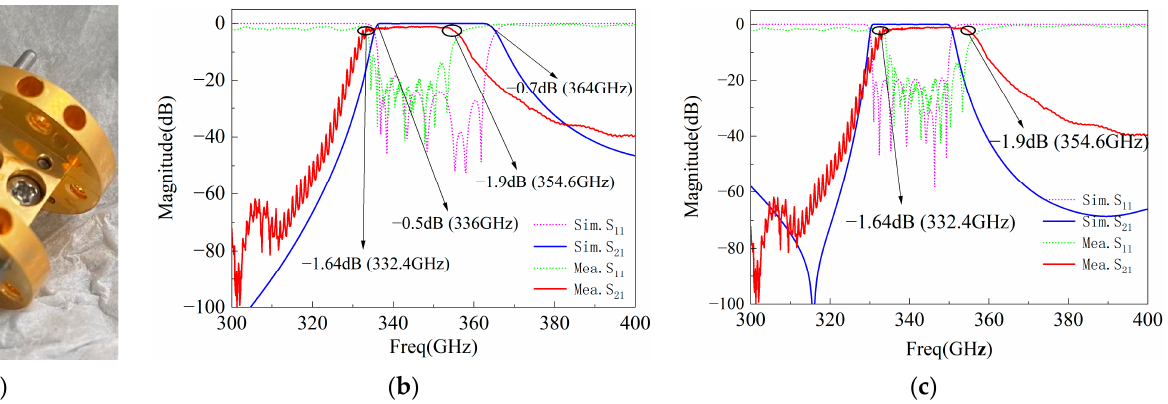
Figure 5. Second fabricated terahertz filter. ( a ) Fabricated terahertz filter based on GOC method; ( b ) Comparison between measured and simulation results; ( c ) Comparison between measured and de- sired results.